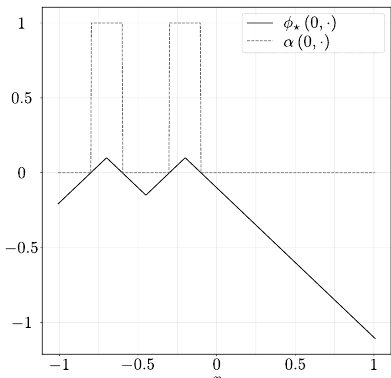
Figure 2. Initial condition of the advection equation (dashed) and the signed distance function to the desired interface (solid).